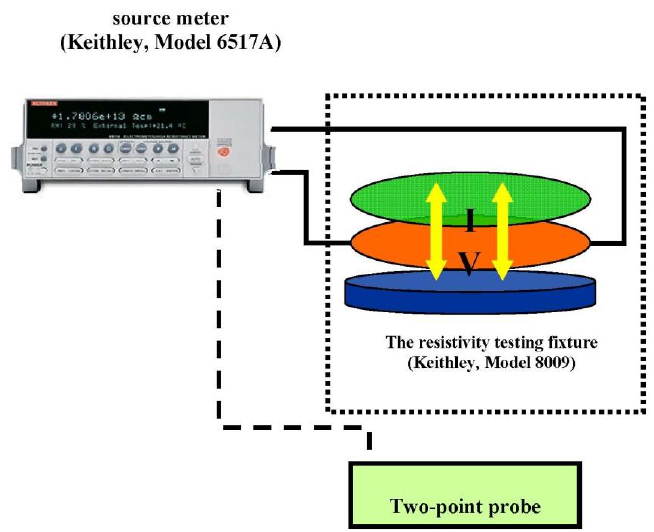
Figure 1. Electrical conductivity